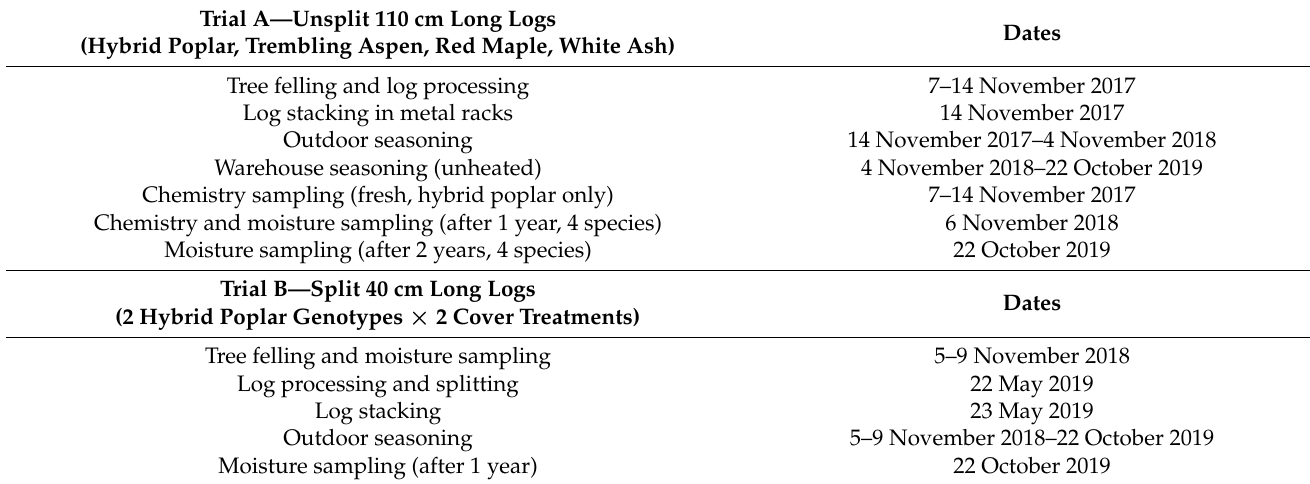
Table 1. A summary of key dates related to firewood processing and sampling for Trials A and B. Trial A—Unsplit 110 cm Long Logs (Hybrid Poplar, Trembling Aspen, Red Maple, White